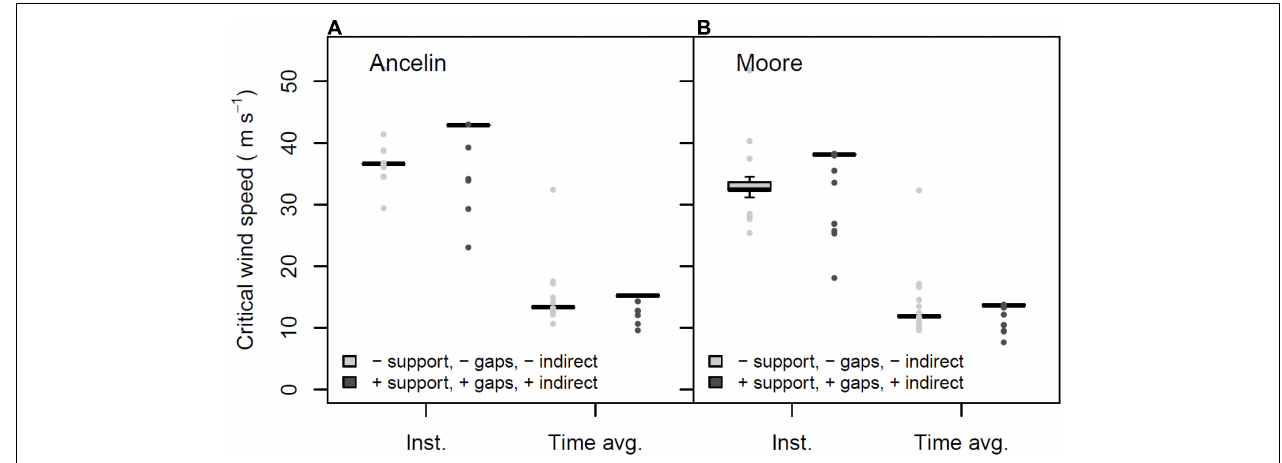
FIGURE 9 | Mean, 25% and 75% percentiles, 1.5 × interquartile range (whiskers), and outliers of critical wind speed (CWS) in m s − 1 , for intact forest under two profile families, presented as time-averaged mean wind speeds and instantaneous wind speeds. (A) Profile family Ancelin; (B) profile family Moore. Parameters constant across figure: stand orientation = A; alpha = 3.0 or LAI = 3.5.